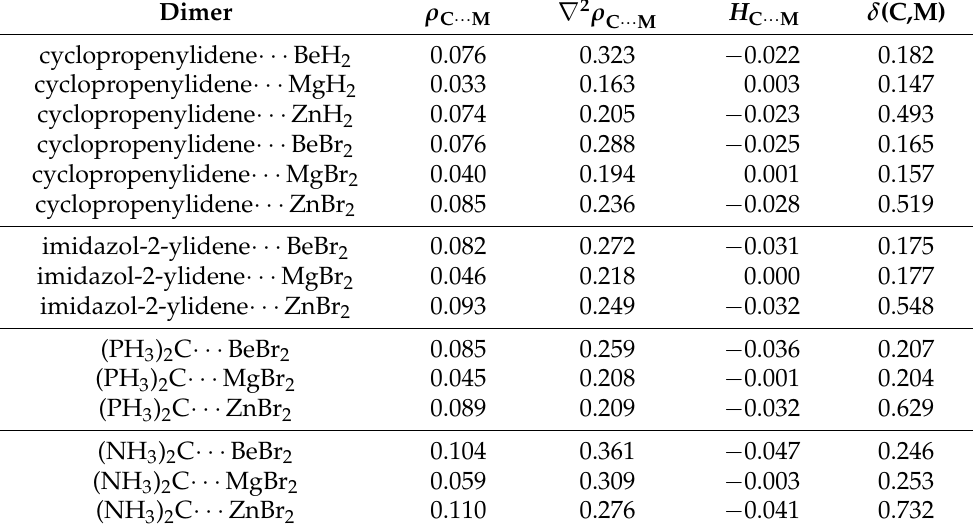
Table 5. Some fundamental QTAIM-based parameters (in au) characterizing carbene · · · MX 2 and CDP · · · MX 2 dimers: the electron density ( ρ C ··· M ), its Laplacian ( ∇ 2 ρ C ··· M ) and the total electronic energy density ( H C ··· M ) computed at the C · · · M bond critical point, the delocalization index of the C and M atomic basins ( δ